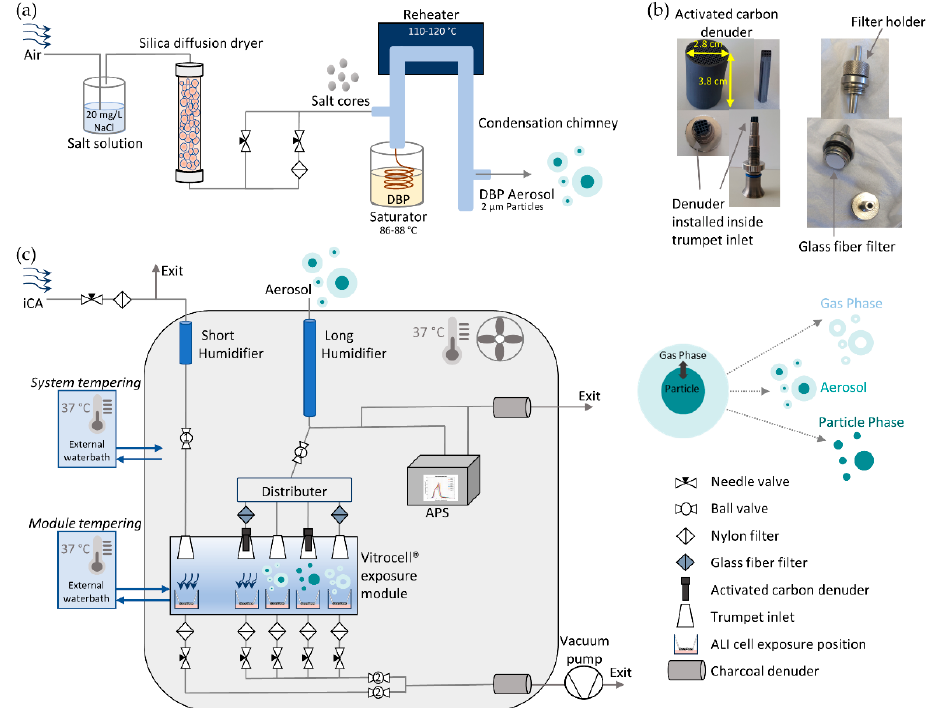
Figure 1. Detailed experimental set-up depicting the aerosol generation and in vitro ALI cell exposure system unit. ( a ) Scheme of the modified TOPAS SLG270 aerosol generator connected to the salt nucleation core production line. The salt cores are guided to the generator leading to formation of the liquid DBP (dibutyl phthalate) aerosol. ( b ) Activated carbon denuders are installed inside the trumpet inlet of the Vitrocell ® exposure module for pure particle phase exposures; glass fiber filters in manufactured holders are set upfront the trumpet inlet for pure gas phase exposures. ( c ) Detailed set-up of the exposure system including new exposure system and external components. APS = Aerodynamic Particle Sizer, iCA = independent clean air connection